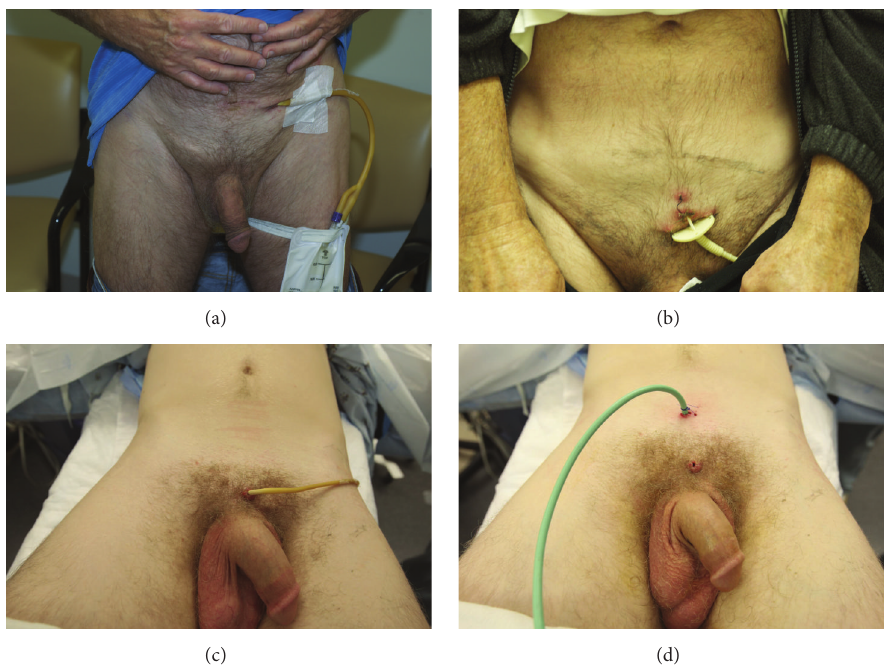
Figure 1: (a) Laterally placed suprapubic tube. (b) Small “pigtail” catheter of inadequate caliber. (c) Suprapubic tube placed below the ideal location. (d) Suprapubic tube repositioned midline 2-finger breadth above the midline pubic